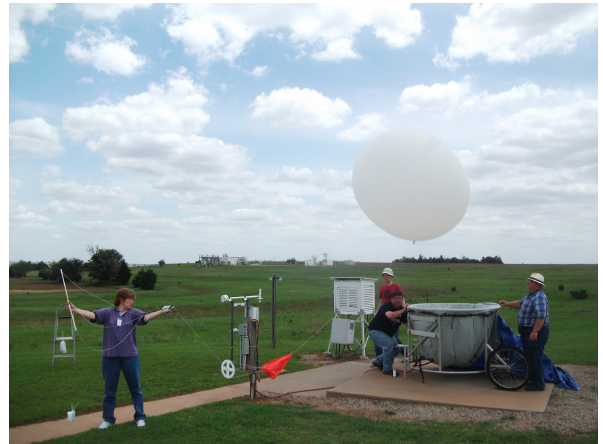
Figure 4. Radiosonde launch at the ARM Southern Great Plains site. Table 5. Radiosonde launch characteristics.